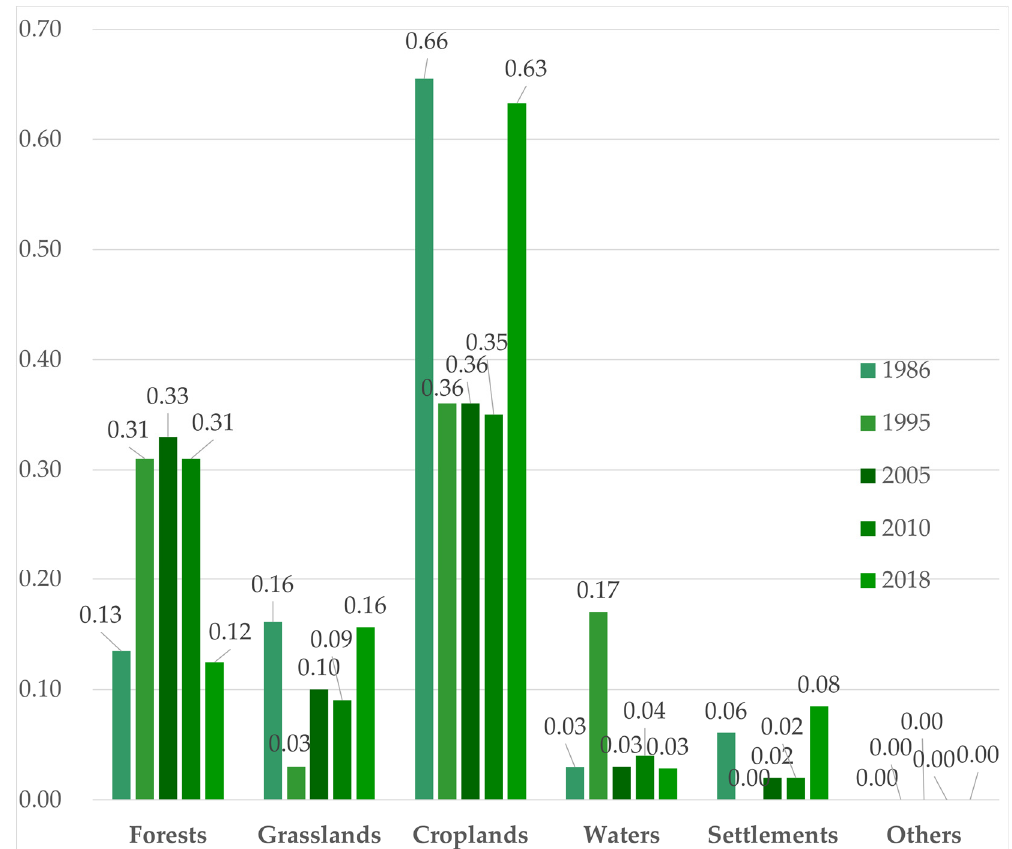
Figure 6. Changes in the PD values from 1986 to 2018.